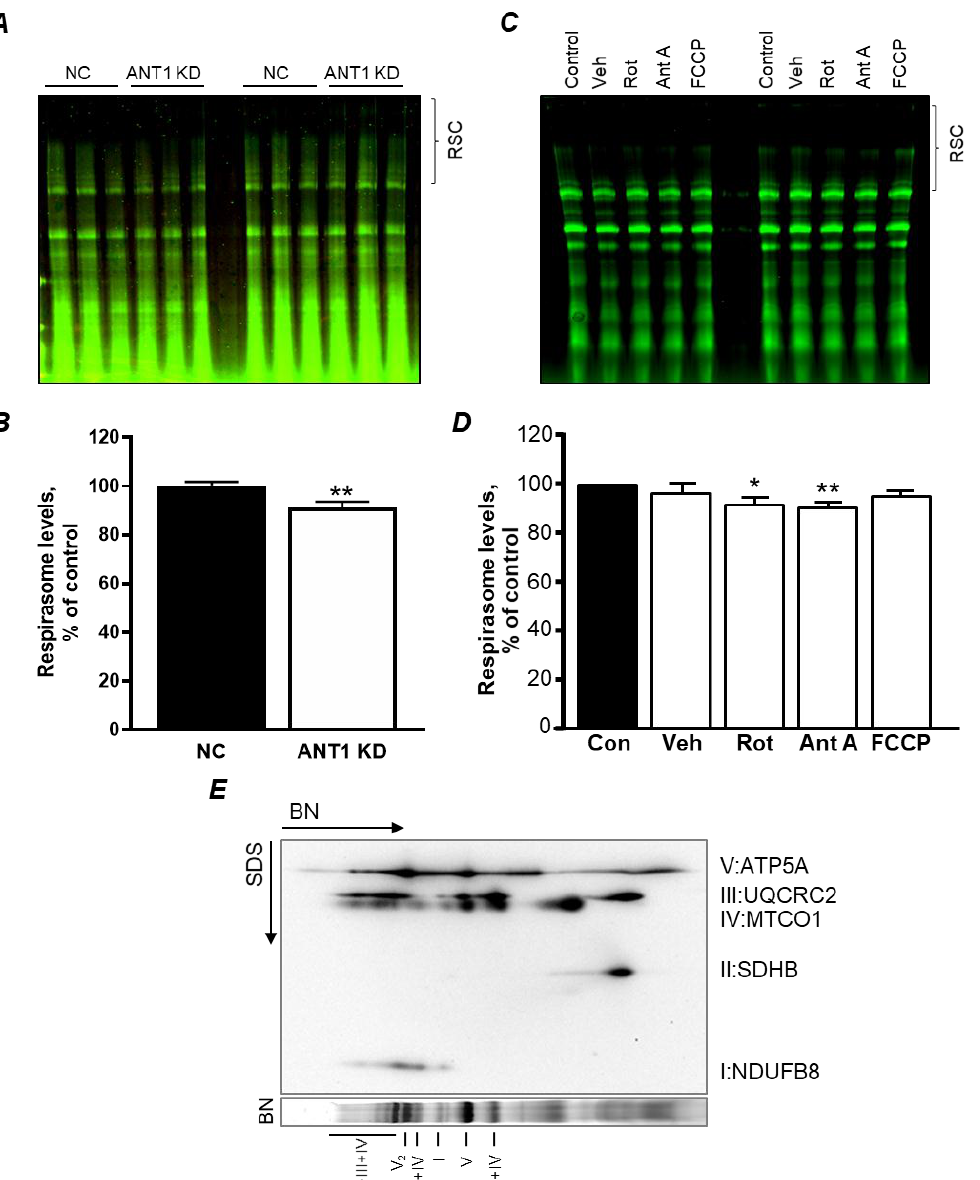
Figure 4. ANT1 KD stimulates mitochondrial respirasome disintegration in H9c2 cells. ( A ) representative blue native (BN) gel of mitochondria isolated from ANT1 KD cells and subjected to BN-PAGE; ( B ) quantitative data of respirasome levels; ( C ) representative BN-PAGE gel of mitochondria isolated from rat heart and treated with vehicle (Veh, 0.01% DMSO), 500 nM rotenone (Rot), 500 nM antimycin A (Ant A), or 1 µ M FCCP; ( D ) quantitative data of respirasome levels in the groups shown in C; ( E ) representative two-dimensional BN-PAGE of ETC complexes in mitochondria isolated from the rat heart. RCS were analyzed in mitochondria where membrane proteins were solubilized using digitonin and separated by BN-PAGE. ETC complexes were visualized using specific antibodies against the subunits for complexes I (NDUFB8), II (SDHB), III (UQCRC2), IV (MTCO1), and V (ATP5A). Respirasome is shown as I + III + IV. Data in B and D were normalized to mitochondrial protein levels and presented as percent change of negative control (NC) or control (Con). * P < 0.05 and ** P < 0.01 vs. NC or Con. Data represent 3–4 independent